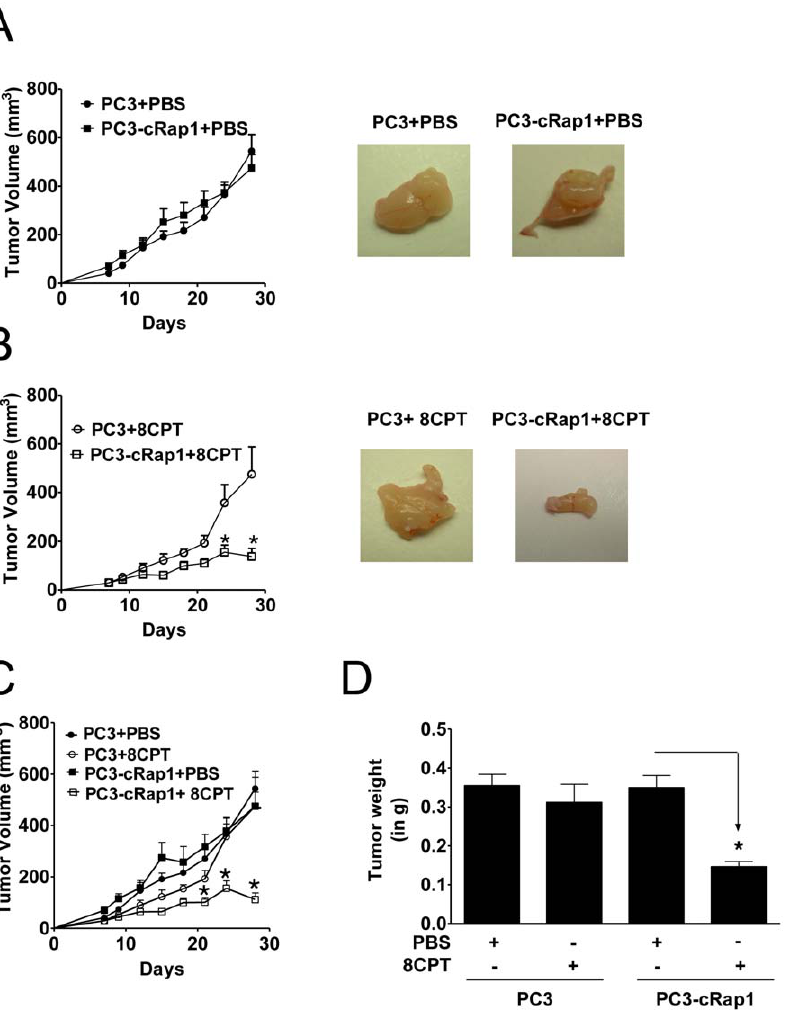
Figure 1. Effect of constitutive Rap1 expression (cRap1) and/or 8CPT treatment on PC3 xenograft growth. (A and B) Left Panel : Tumor volume (expressed in mm 3 ) of human PC3 and PC3-cRap1 xenografts treated as indicated was measured as described in Methods. Day 0 represents the first day of treatment; *p , 0.05, n=7 for each group. Right Panel : Images of a representative tumor from each treatment group at the end of the experiment (Day 28). (C) Tumor volume (expressed in mm 3 ) of human PC3 and PC3-cRap1 xenografts treated as indicated was measured as in A; *p , 0.05, n=7 for each group. (D) Tumors from panel C were weighed at the end of the experiment (Day 28) and expressed in grams; *p , 0.05; ( n =7).